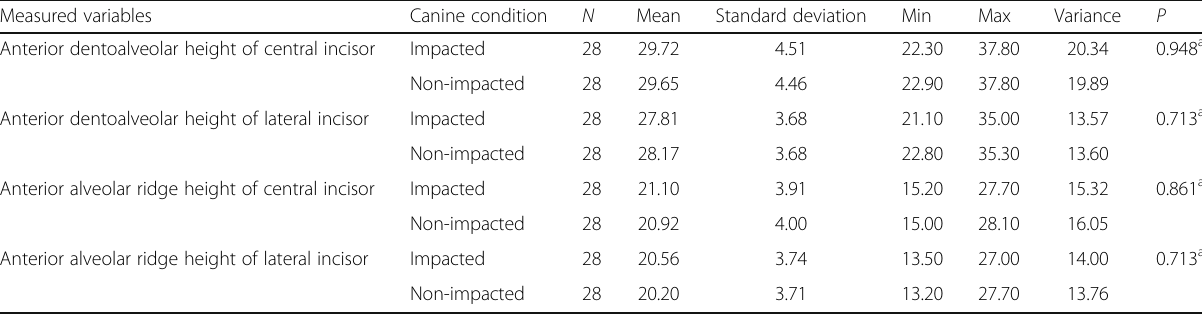
Table 3 Comparison of heights of skeletal and dentoalveolar variables obtained in the maxilla depending on the condition side of impaction Measured